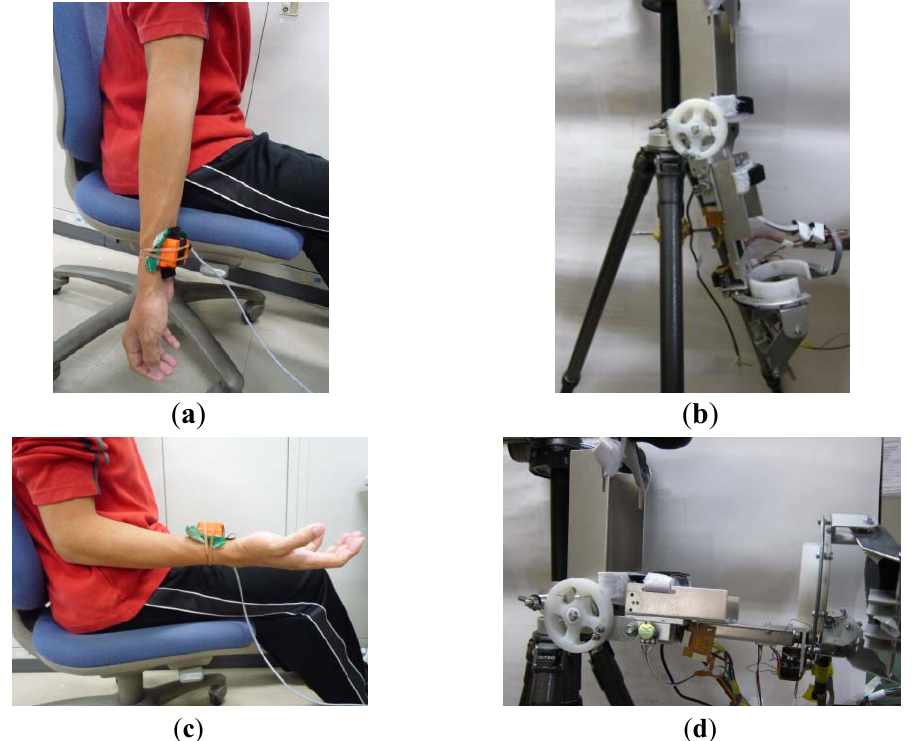
Figure 7. The disconnected experiment. ( a ) The subject’s forearm on the vertical plane with the inertia sensor on his wrist; ( b ) The ULERD is extended to the vertical plane; ( c ) The subject’s forearm on the horizontal plane with the inertia sensor on his wrist; ( d ) The ULERD is extended to the horizontal